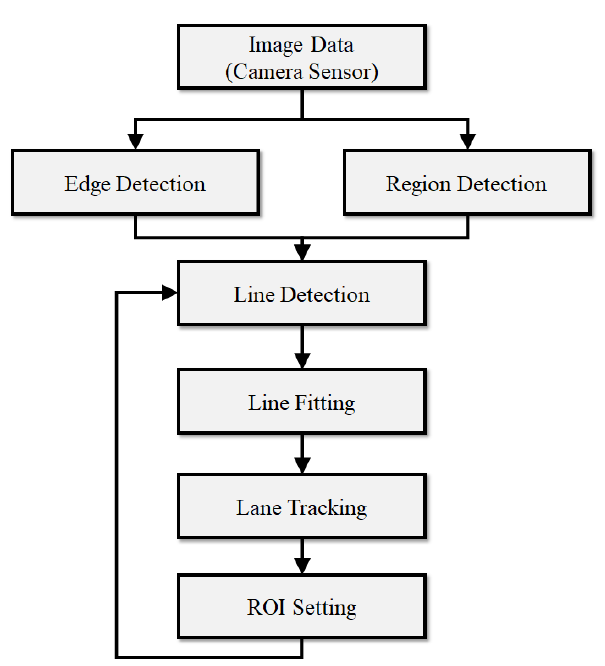
Figure 6. Block diagram for general lane detection